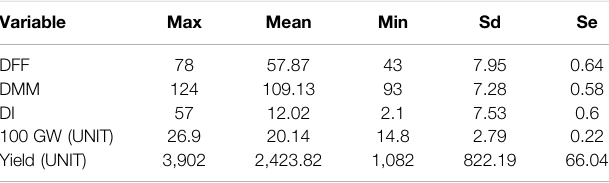
TABLE 3 | Descriptive statistics involving Maximum (Max), Mean, Minimum (Min), standard deviation (Sd) and Standard error (Se). Variable